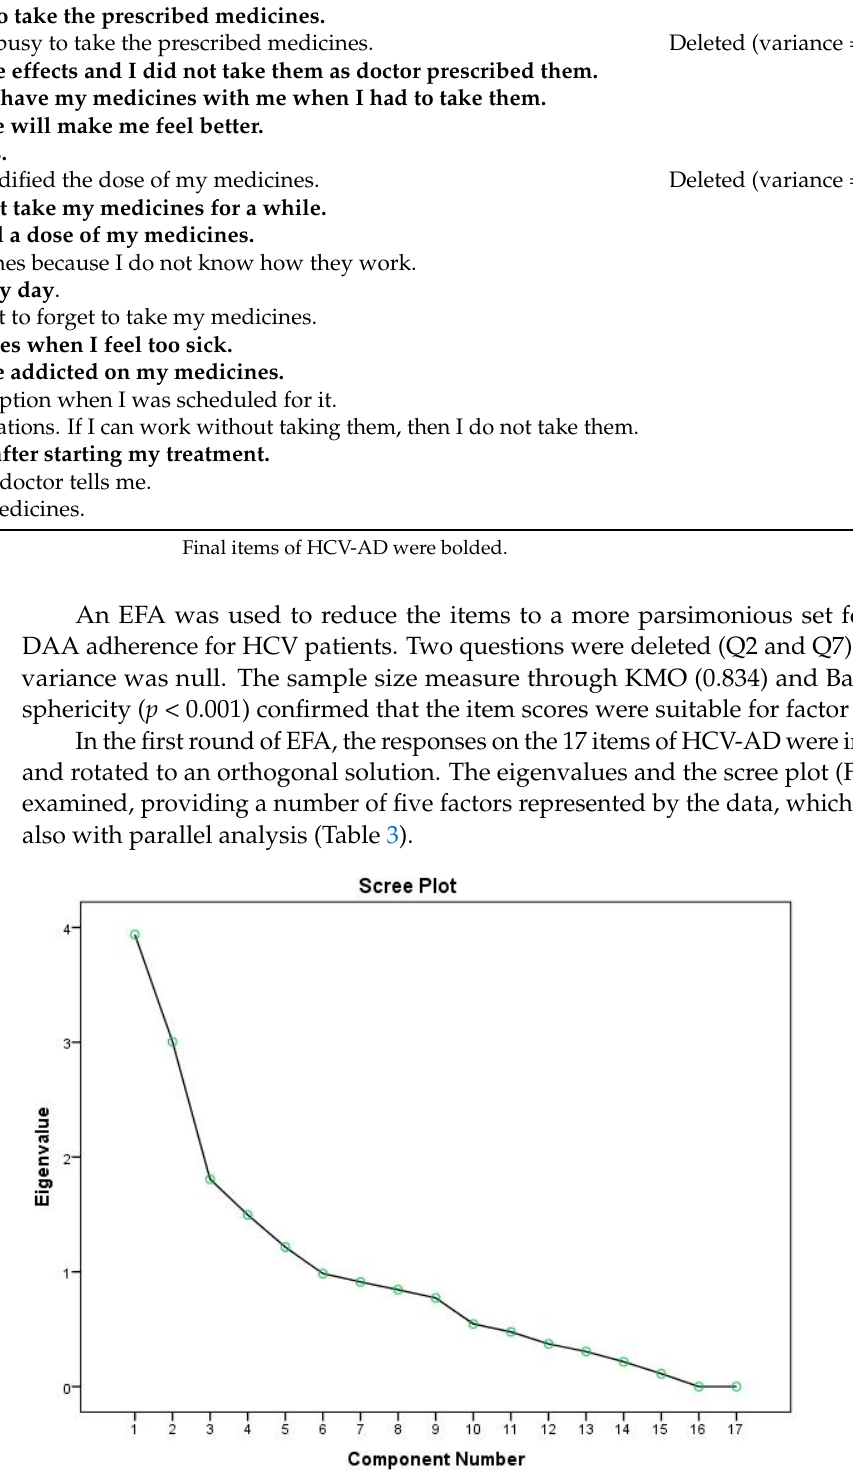
Table 3. The total variance explained with Eigenvalues using EFA.